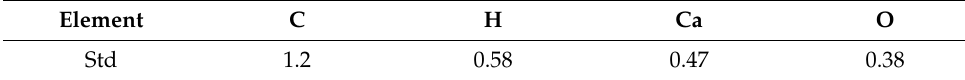
Table 4. Standard deviation of selected elements in aggregates.